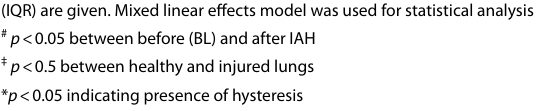
4. Table: Effect of PEEP on inspiratory lung aeration. While lung injury decreased gas volumes, IAH decreased gas volumes only in healthy but not in injured lungs